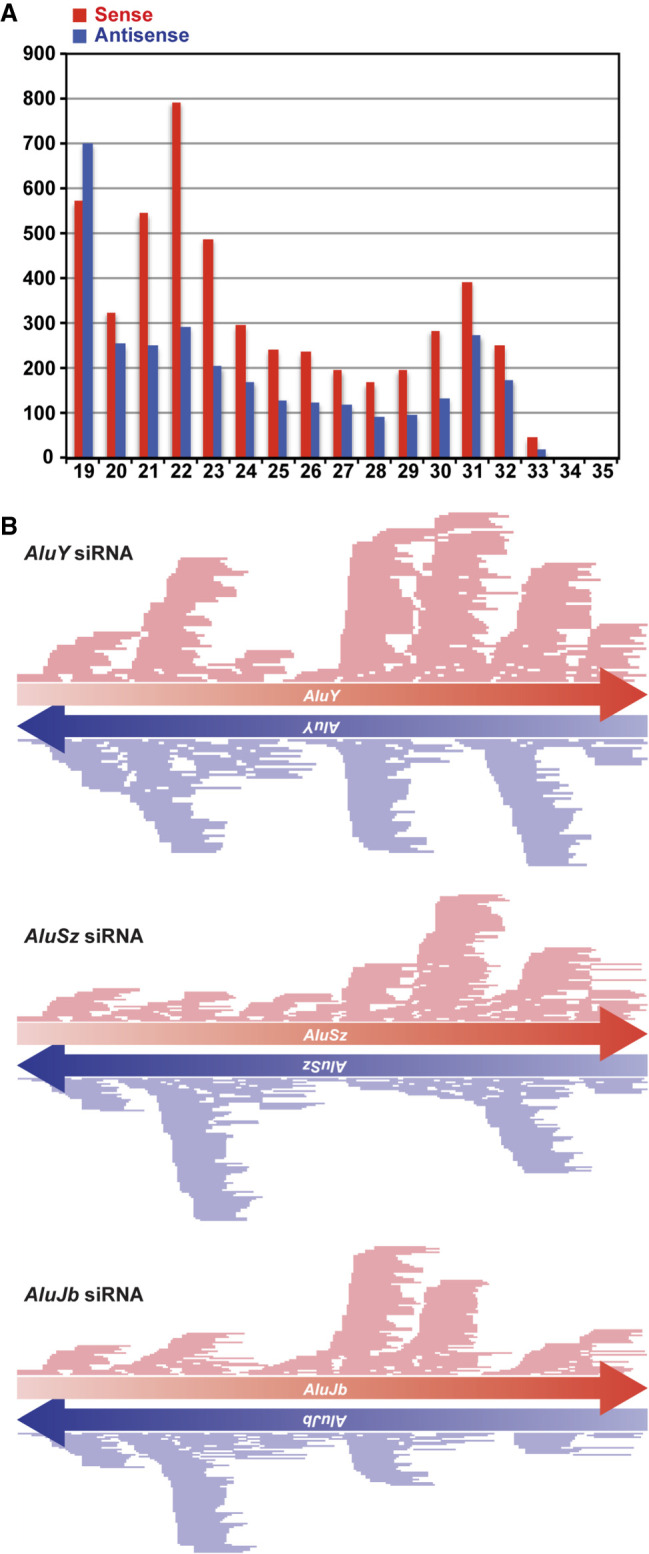
Alu siRNA expression in HeLa cells. (A) The length distribution of Alu-derived small RNAs in HeLa cells. y-axis: counts per million reads; x-axis: base length. (B) Distribution of Alu siRNAs corresponding to sense and antisense strands of consensus AluY, AluSz, and AluJb sequences (UCSC genome database). RNAs of 19 to 24 nt in length were used as siRNAs.